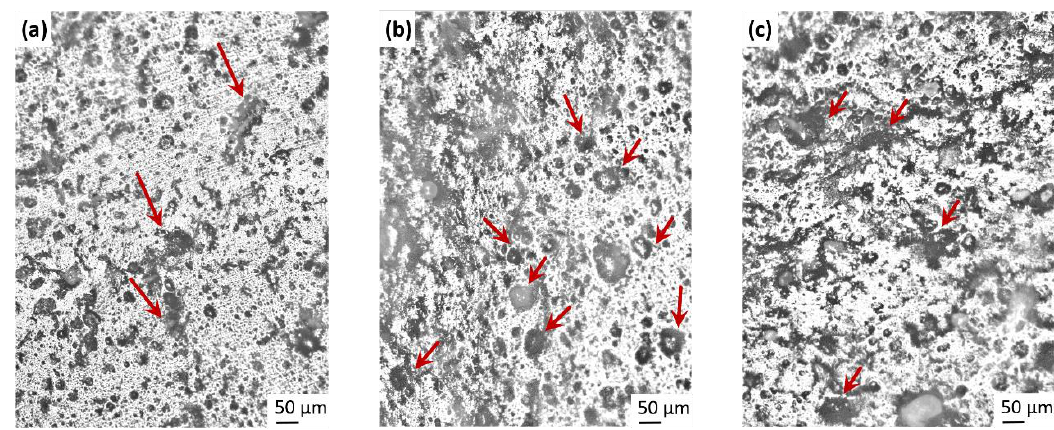
Figure 5. Light microscopy images of uncured blends after 10 min of mixing. Analyses at 100 × overall magnification for silica-filled SBR/BR blends without ( a ); with 5 phr ( b ); and with 20 phr ( c ) TDAE content.